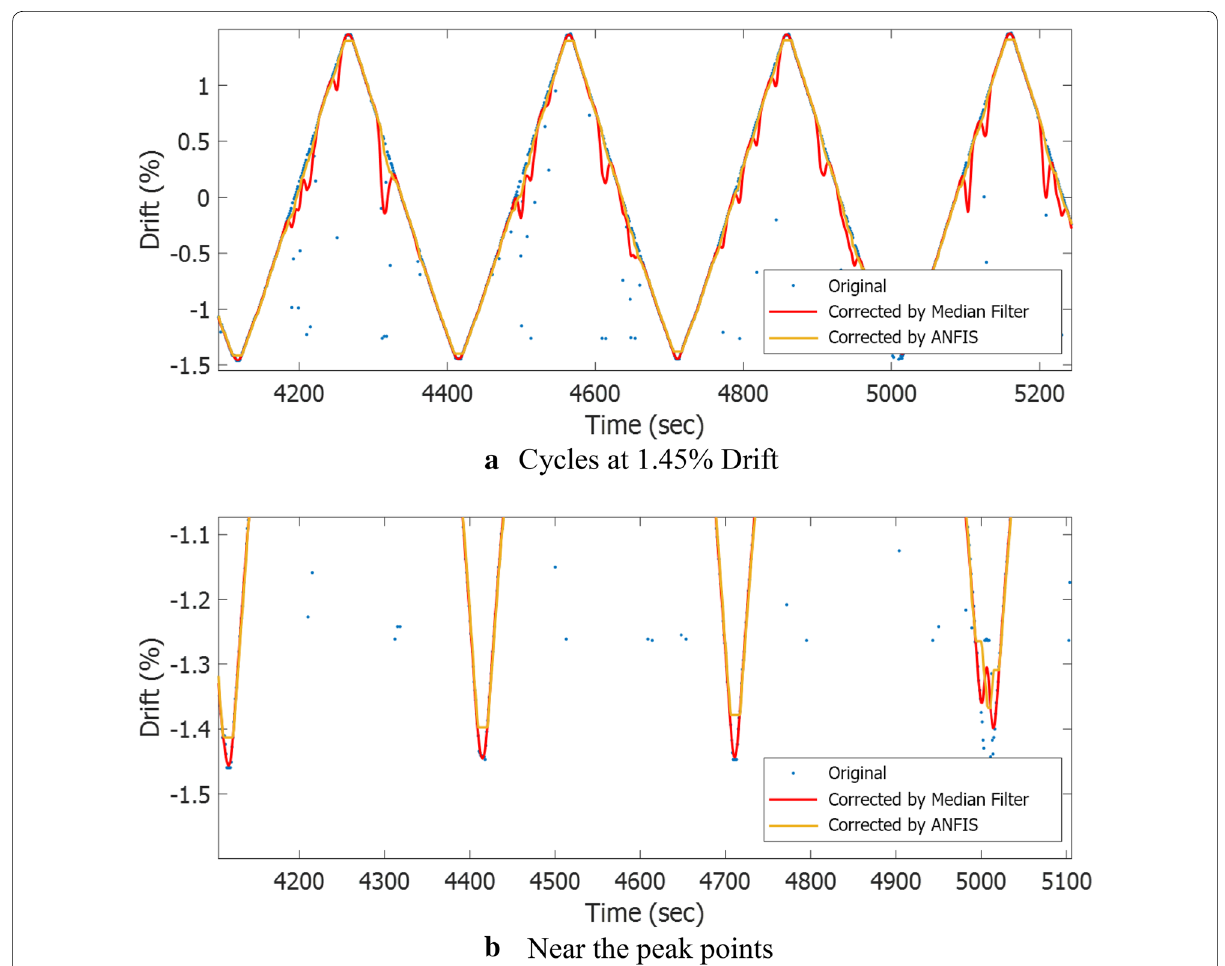
Fig. 17 Comparisons of original, corrected displacement by ANFIS and median